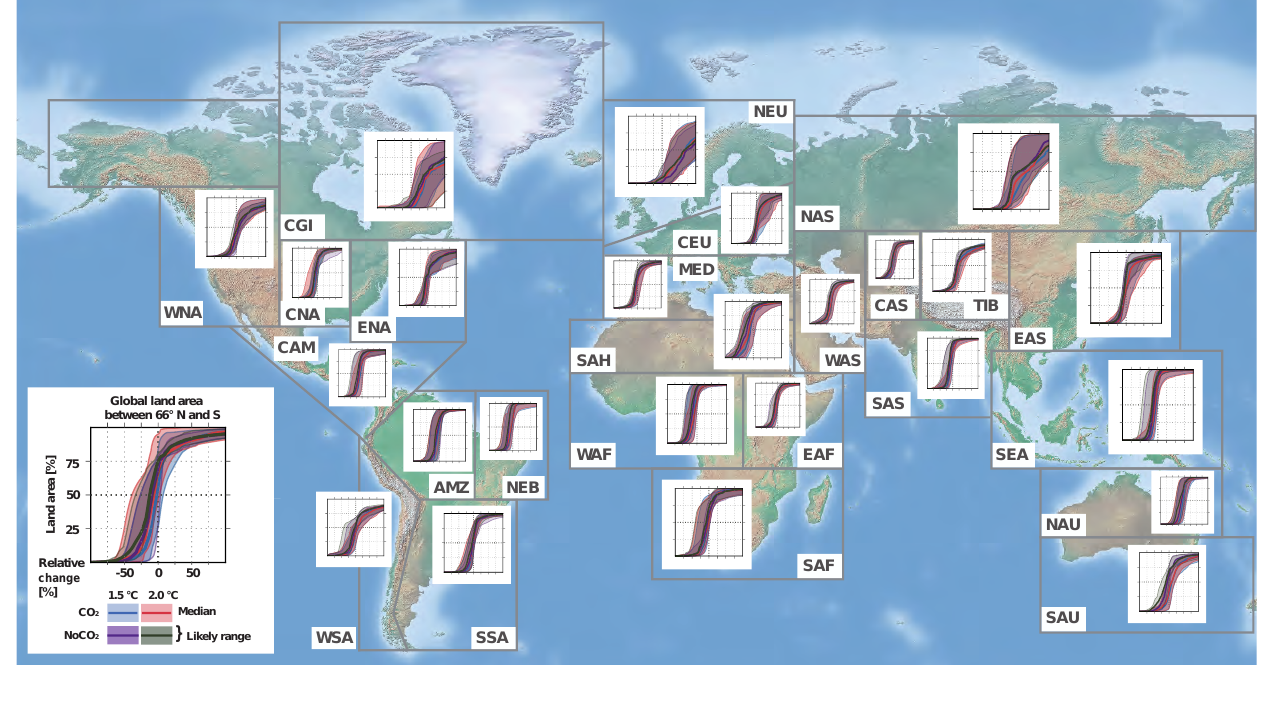
Figure 10. Same as Fig. 9, but for changes in maize yields.